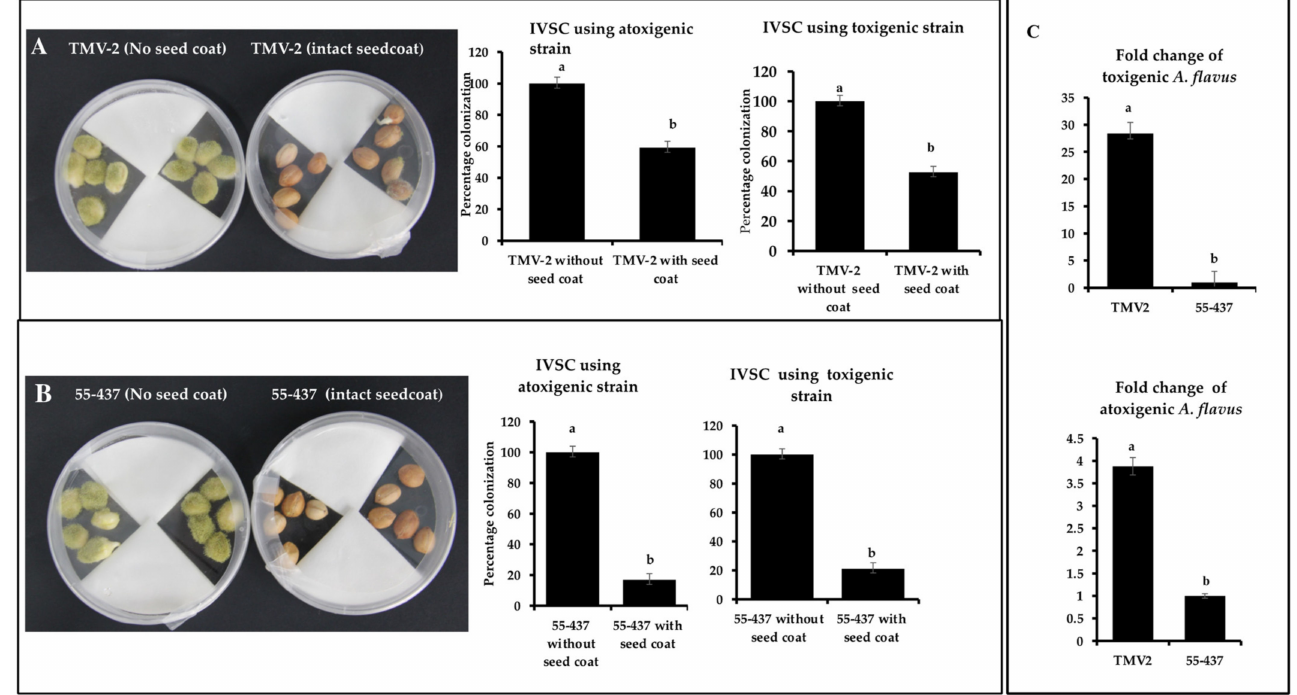
Figure 1. In-vitro seed colonization assay of peanut lines 55-437 and TMV-2 with and without seed coat. Sterilized peanut seeds of TMV-2 ( panel ( A )) and 55-437 ( panel ( B )) with intact seed coat and without seed coat inoculated with aflatoxigenic (isolate 3) and non-aflatoxigenic (isolate 5) A. flavus strains. Percentage of colonization was calculated as (number of seeds colonized by the pathogen)/(total number of seeds) × 100. The data is an average of three technical replicates and three biological replicates. The fungal abundance of toxigenic and atoxigenic A. flavus strains was estimated using qPCR ( panel ( C )). Peanuts from TMV-2 and 55-437 with intact seed coat obtained after IVSC assay was ground and DNA was isolated from the pooled samples and used for relative quantification using qPCR. Fold change for the fungal abundance for toxigenic (upper panel) and atoxigenic (lower panel) stains was calculated from the qPCR data. One-way ANOVA was used to determine the significant difference between different groups. Means not sharing the same letter are significantly different ( p < 0.05). The error bar represents the standard error ( n =